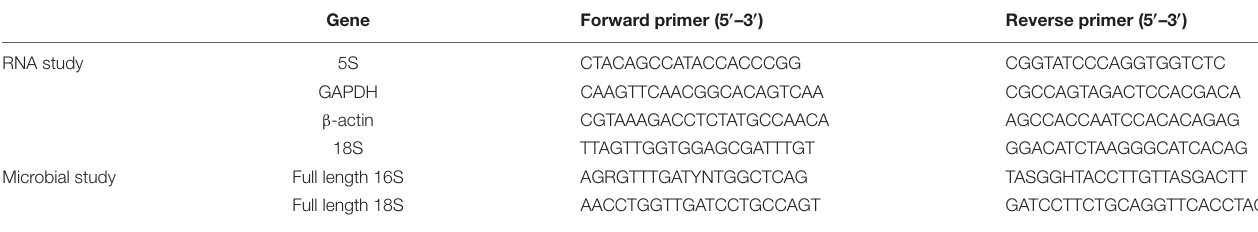
TABLE 1 | Primer sequences used in RNA and microbial experiments. Gene Forward primer (5 (cid:48) –3 (cid:48) ) Reverse primer (5 (cid:48) –3 (cid:48)